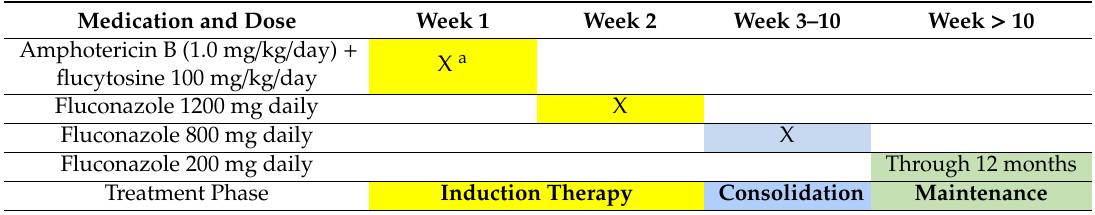
Table 1. The 2018 WHO Antifungal Treatment Recommendations for Cryptococcal Meningitis